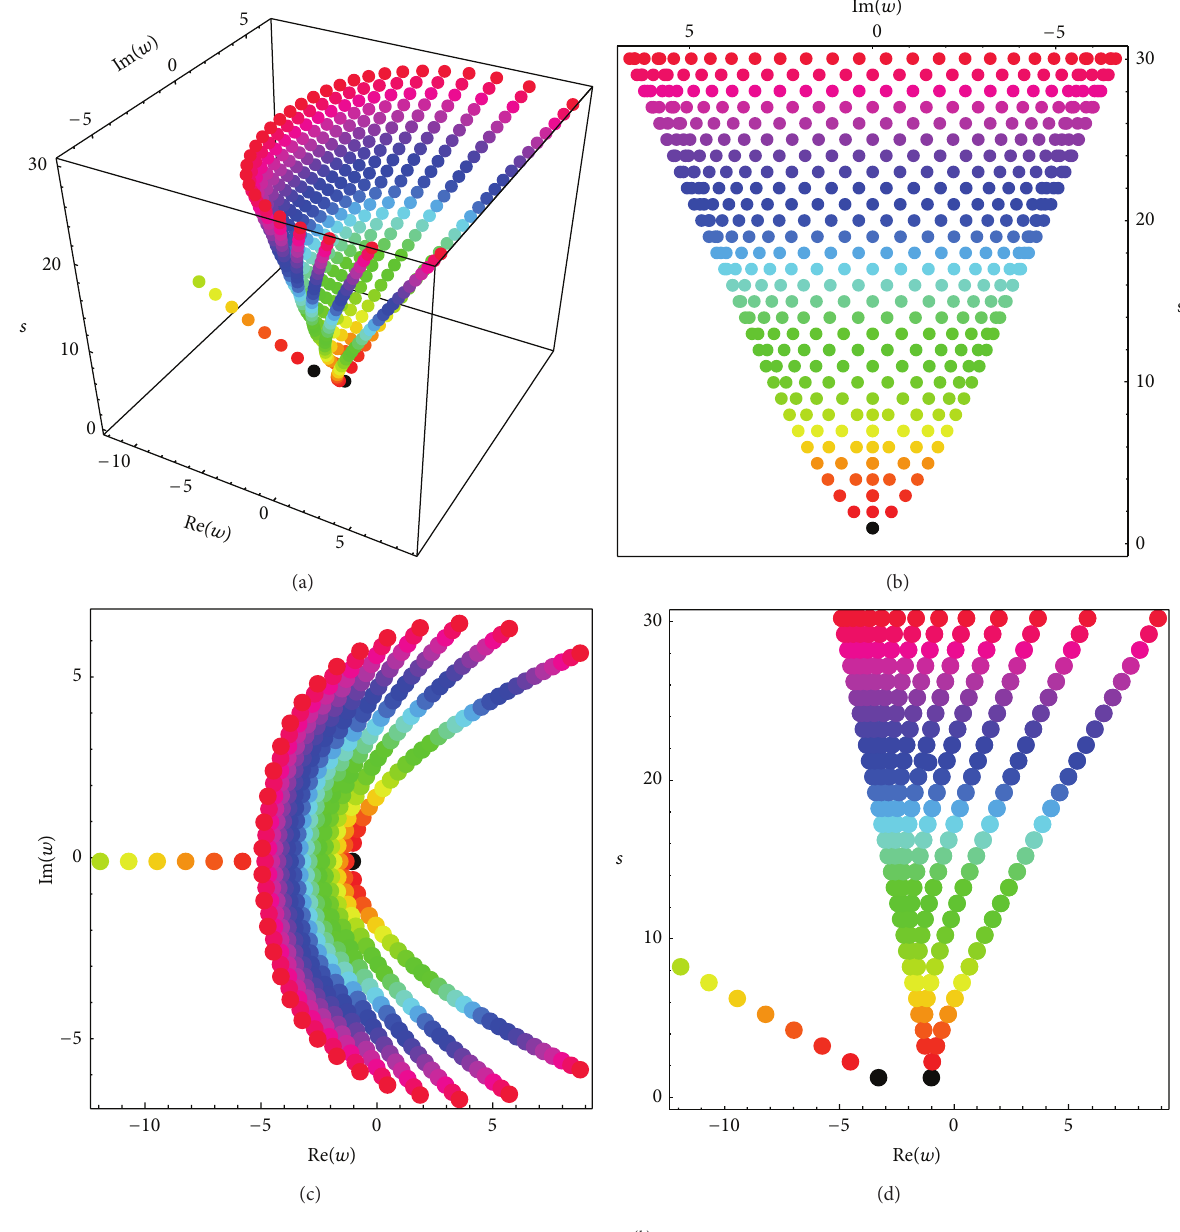
Figure 6: Stacks of zeros of 𝐸 (ℎ) 𝑞 (𝑠,𝑤) for 1 ≤ 𝑛 ≤ 30